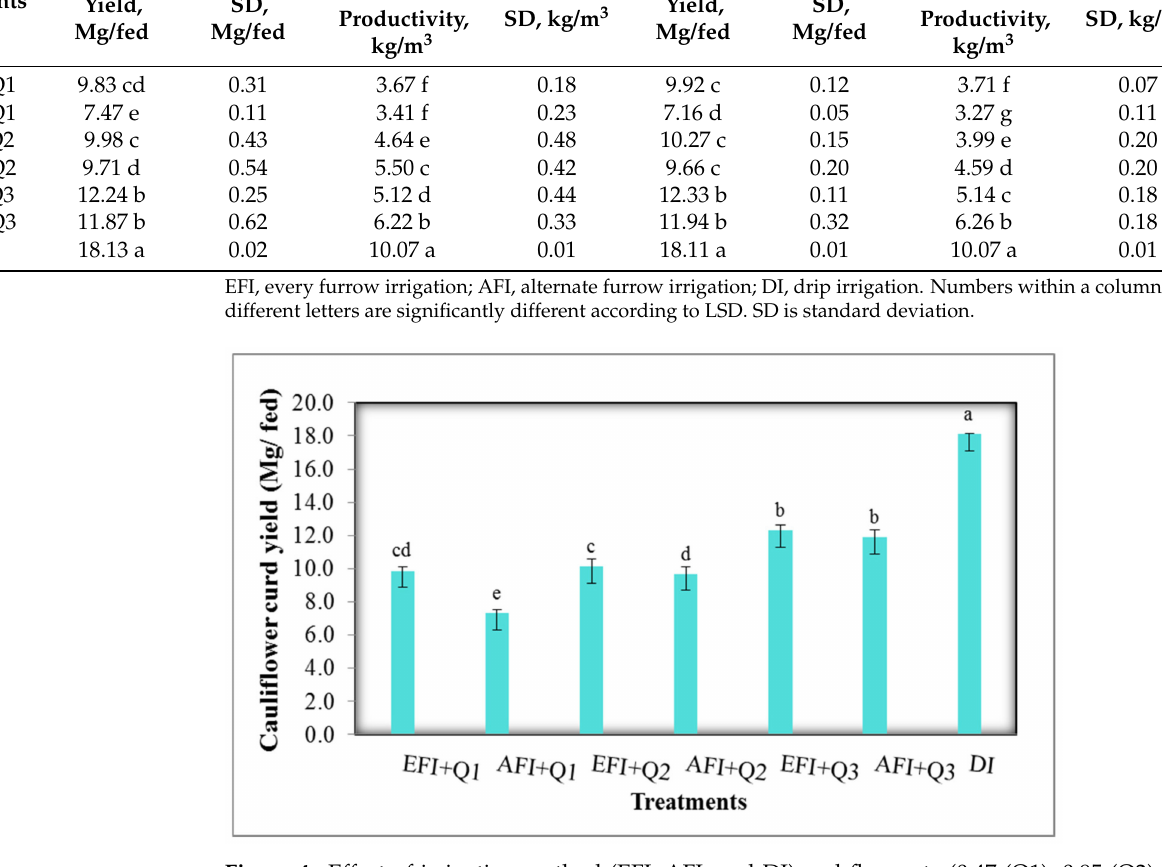
Figure 4. Effect of irrigation method (EFI, AFI, and DI) and flow rate (0.47 (Q1), 0.95 (Q2), and 1.43 L/s (Q3)) on cauliflower curd yield across two seasons. Mean values followed by the same letter were not significantly different at the 5% level between